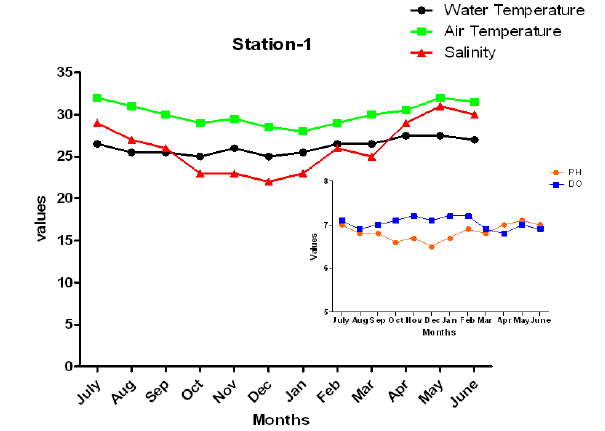
Fig. 2. Hydrographical features at station-1(Pandi backwaters) during July 2006-June 2007